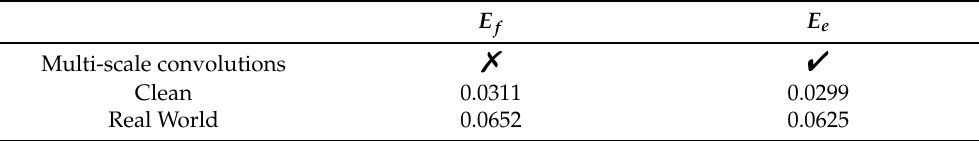
Table 6. Effects of multi-scale convolutions in the proposed network. E f E e Multi-scale convolutions (cid:37) (cid:34) Clean 0.0311 Real World